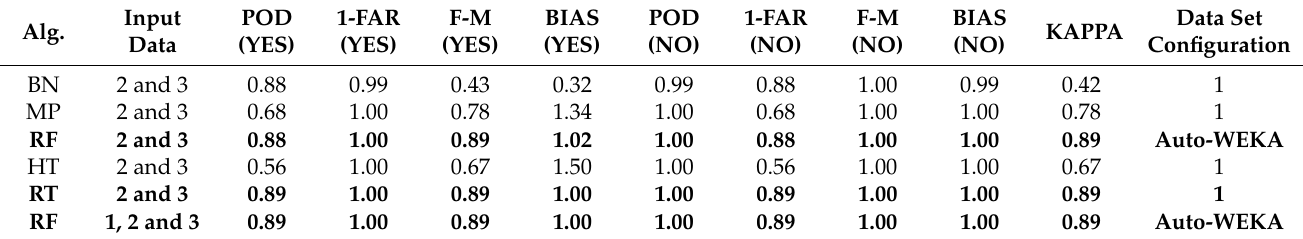
Table 5. Statistical test results of 15 min Vis forecasts ≤ 1600 m for the five algorithms (Alg) selected with input from SODAR (source 1), ASWS (source 2) and observer (source 3). The satisfactory algorithm result is in